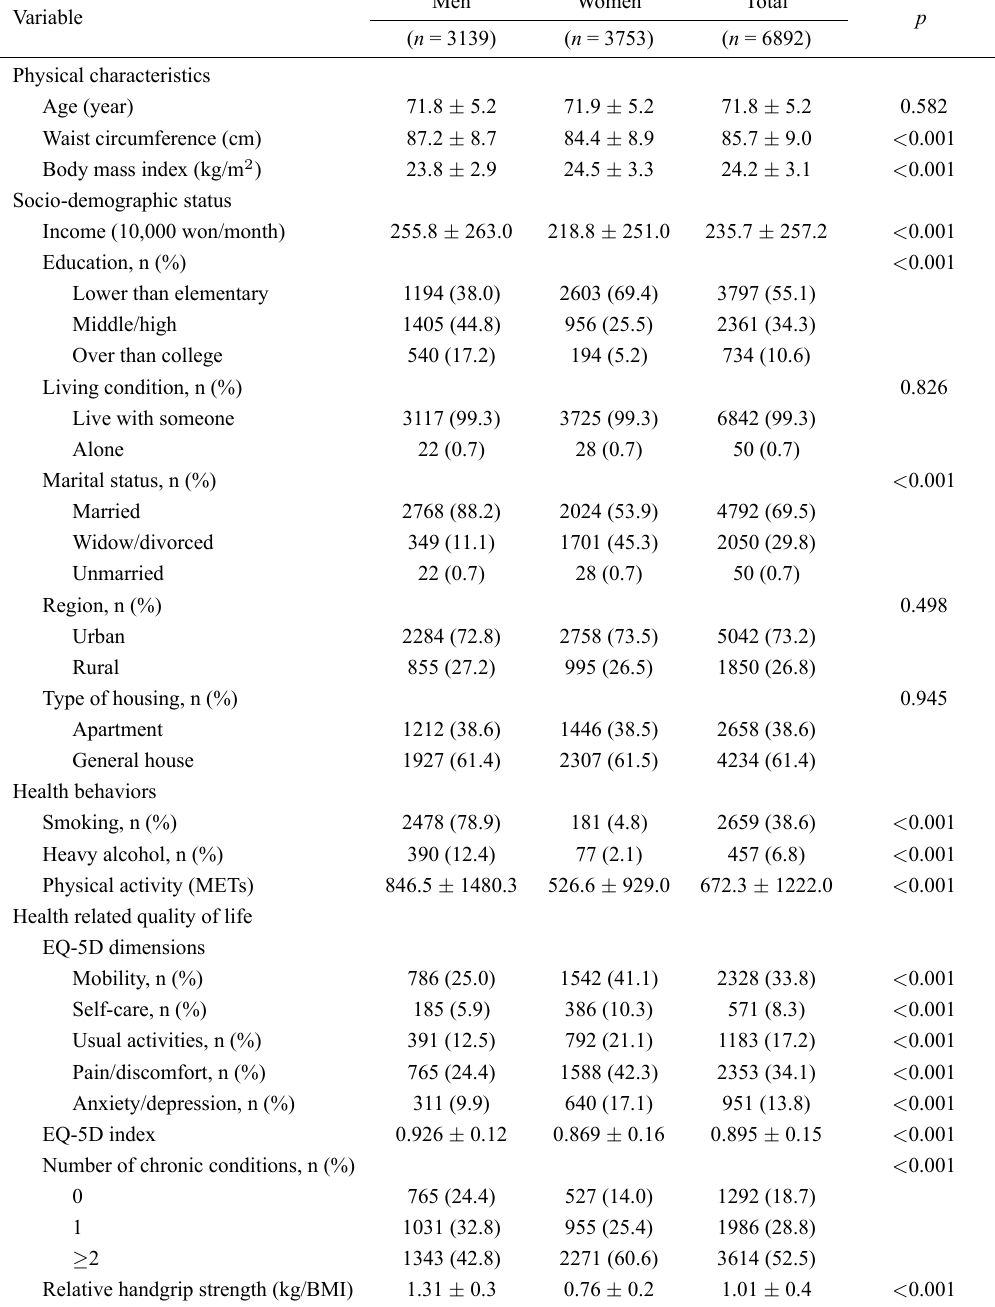
Table 1. Characteristics of study